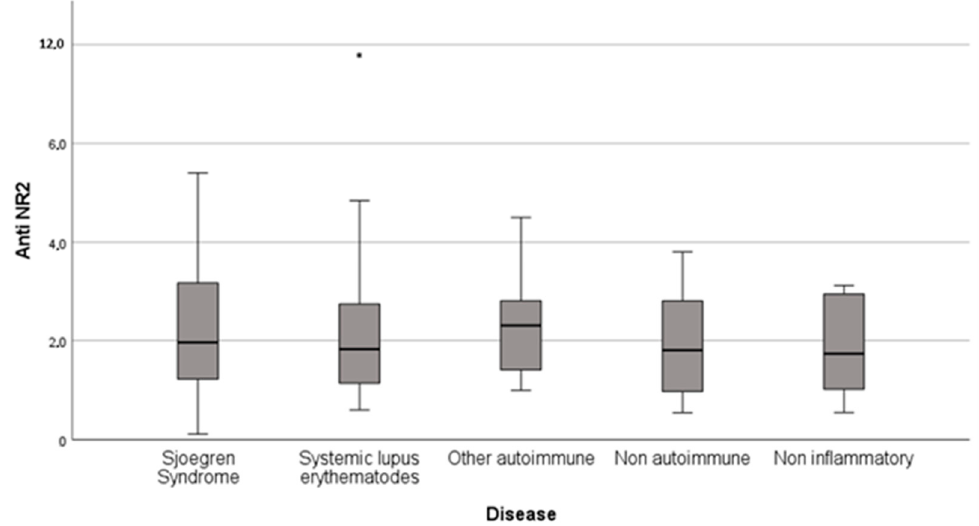
Figure 1. Distribution of anti-NR2 antibody titer in the different groups of fatigued patients with rheumatic diseases.